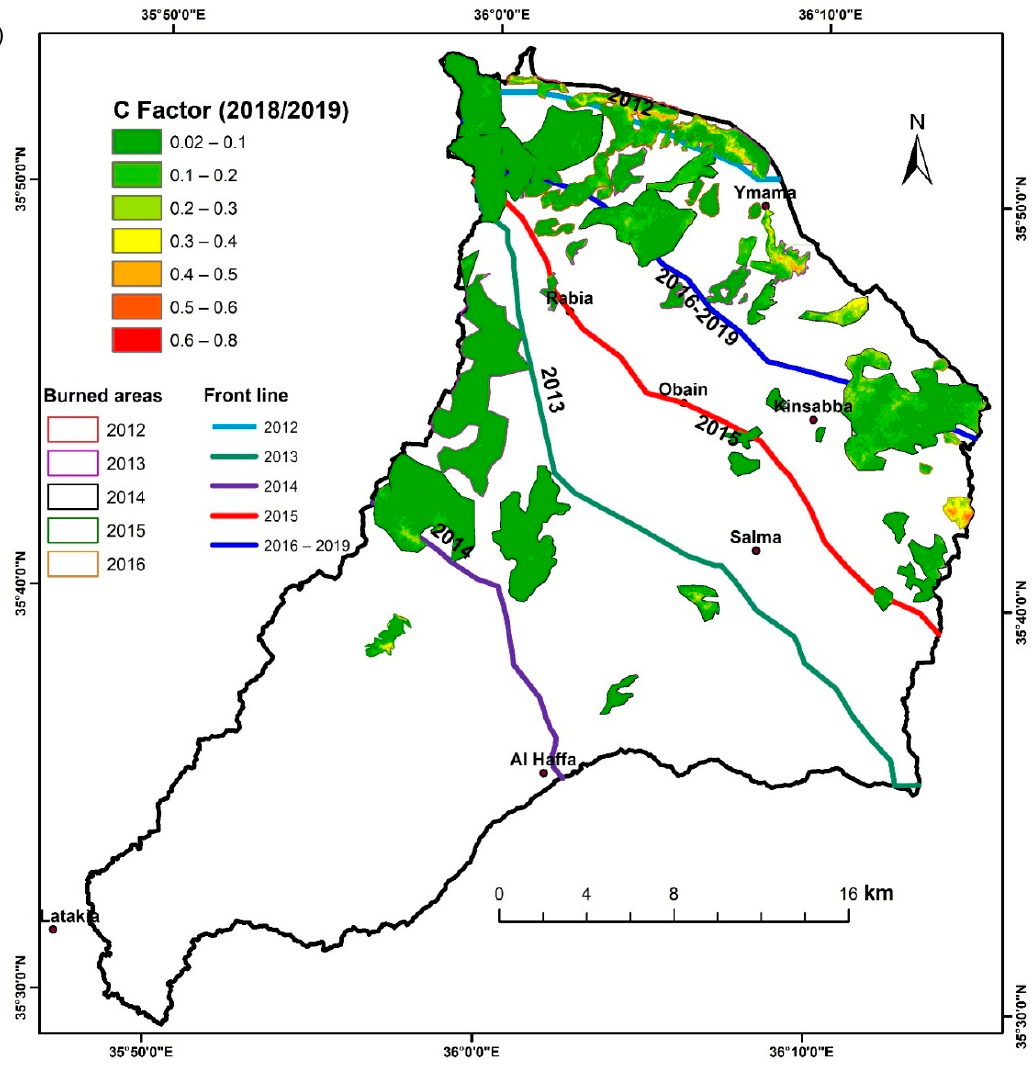
Figure 5. ( a ) Spatial distribution of burned areas and front lines 2012–2019 and the C factor in burned areas in ( b ) 2009/2010, ( c ) 2013/2014 and ( d ) 2018/2019.